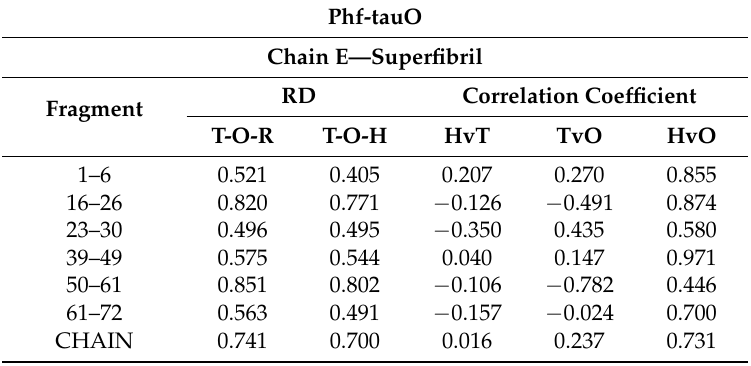
Table 4. RD values in both models (T-O-R and T-O-H), along with HvT, TvO, and HvO correlation coefficients for chains E and F analyzed as part of the superfibril, as part of a protofibril and on their own. Figure 4 illustrates the division of the chain into individual fragments. Phf-tauO Chain E—Superfibril RD Correlation Fragment